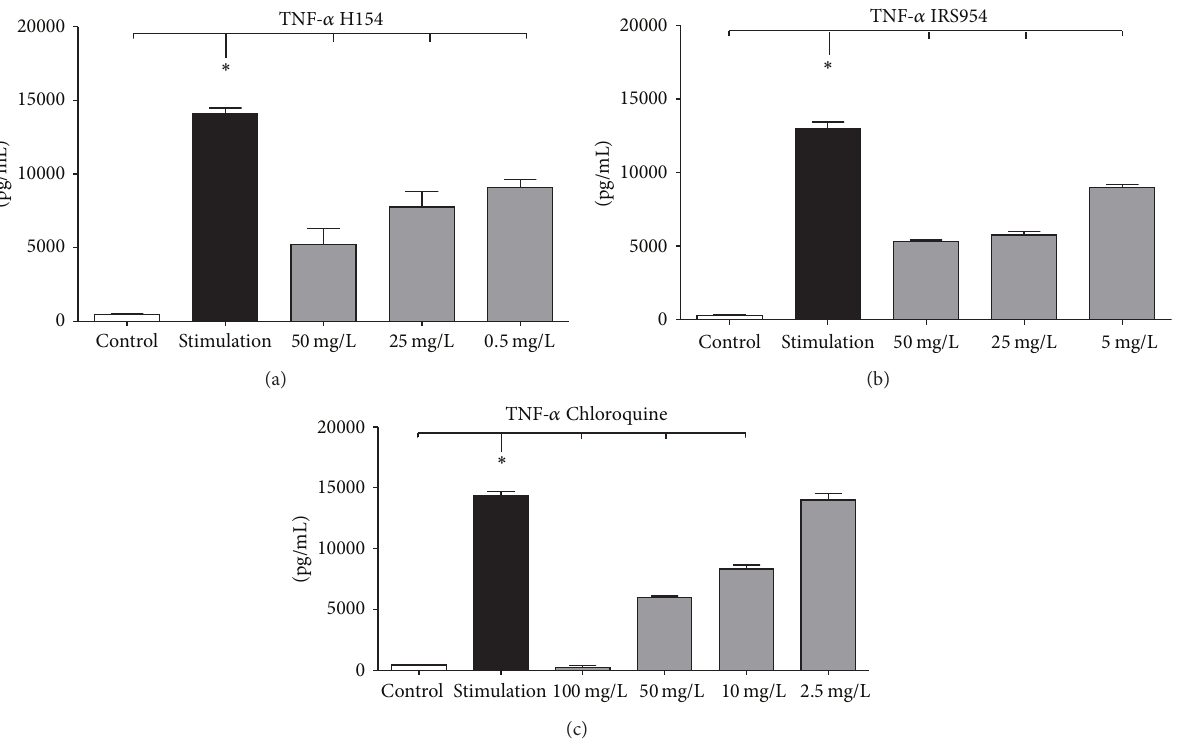
Figure 1: (a)–(c) In vitro evaluation of different doses of TLR9 inhibitors. RAW 264.7 macrophages were stimulated with feces of C57BL/6 WT mice simultaneously with different TLR9 inhibitors for 24 h and TNF- 𝛼 protein content was monitored via ELISA (mean ± SEM; 𝑛 = 5 ; ∗ 𝑃 < 0.05 ; ∗ also indicates the significant